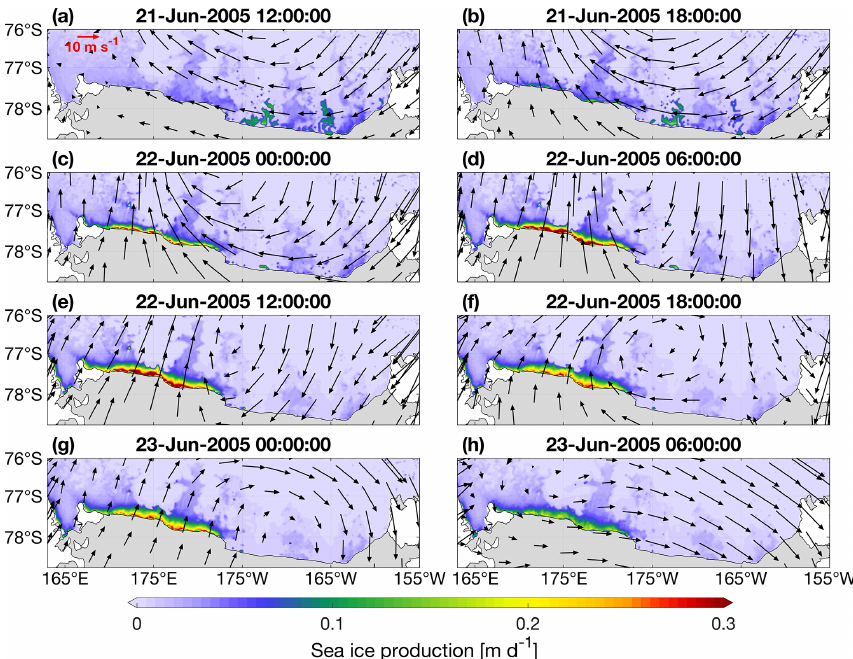
Figure 9. (a–h) Spatial distributions of 6h average wind vectors and sea ice production (colored shading) near the Ross Ice Shelf Polynya over 21–23 June